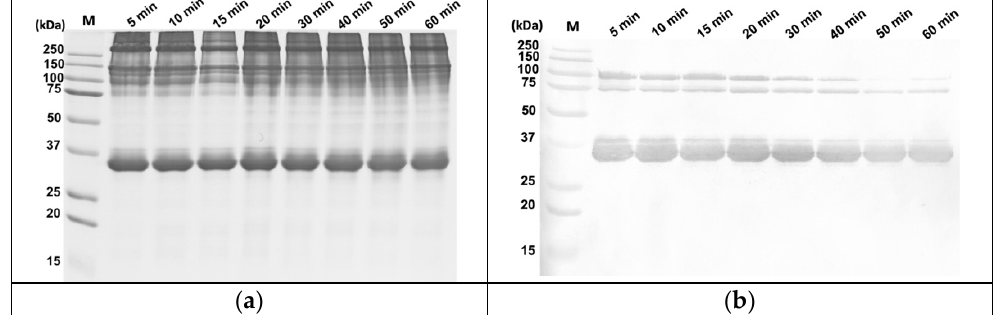
Figure 3. SDS-PAGE ( a ) and western blot analysis ( b ) of cooked cod treated for different heating times using mAb 8F5 supernatant (1:5). The amount of sample loaded on the 12% SDS-PAGE was 15 µ L per lane. M: molecular weight marker.